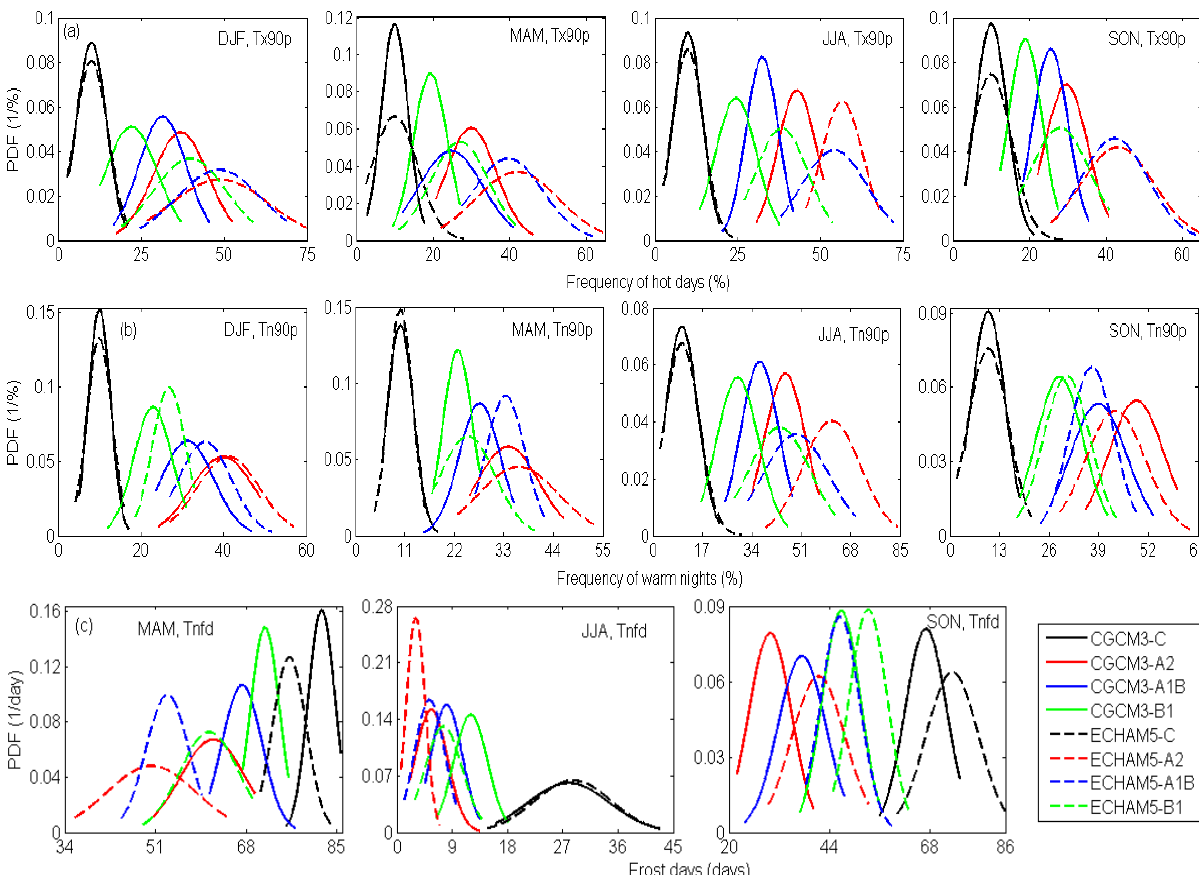
Fig. 8. Fitted normal probability density functions (PDFs) of the frequency-related indices averaged across stations for 2081–2100 and 1961–1990 for four seasons based on statistical downscaling outputs of two GCMs (CGCM3 and ECHAM5) under three emission scenarios (A2, A1B, B1).